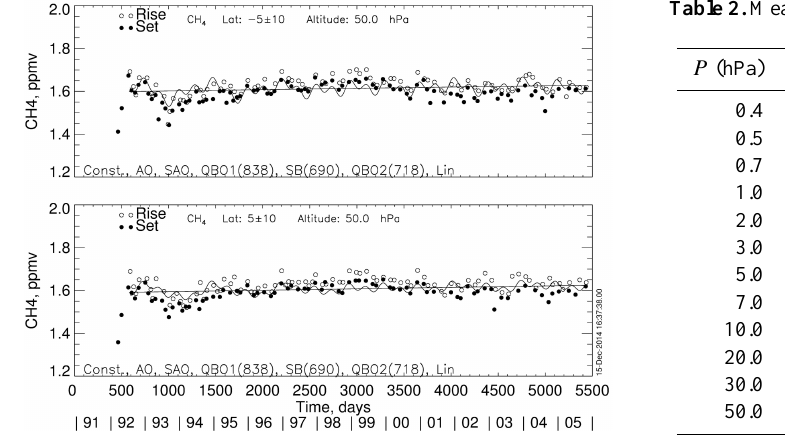
Figure 7. As in Fig. 3, but at 50hPa and at 5 ◦ latitude for the (top) Southern Hemisphere and for the (bottom) Northern Hemisphere.